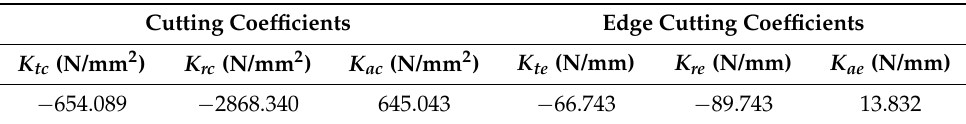
Table 2. Average cutting coefficients of JIS SKD61 (50 HRC).